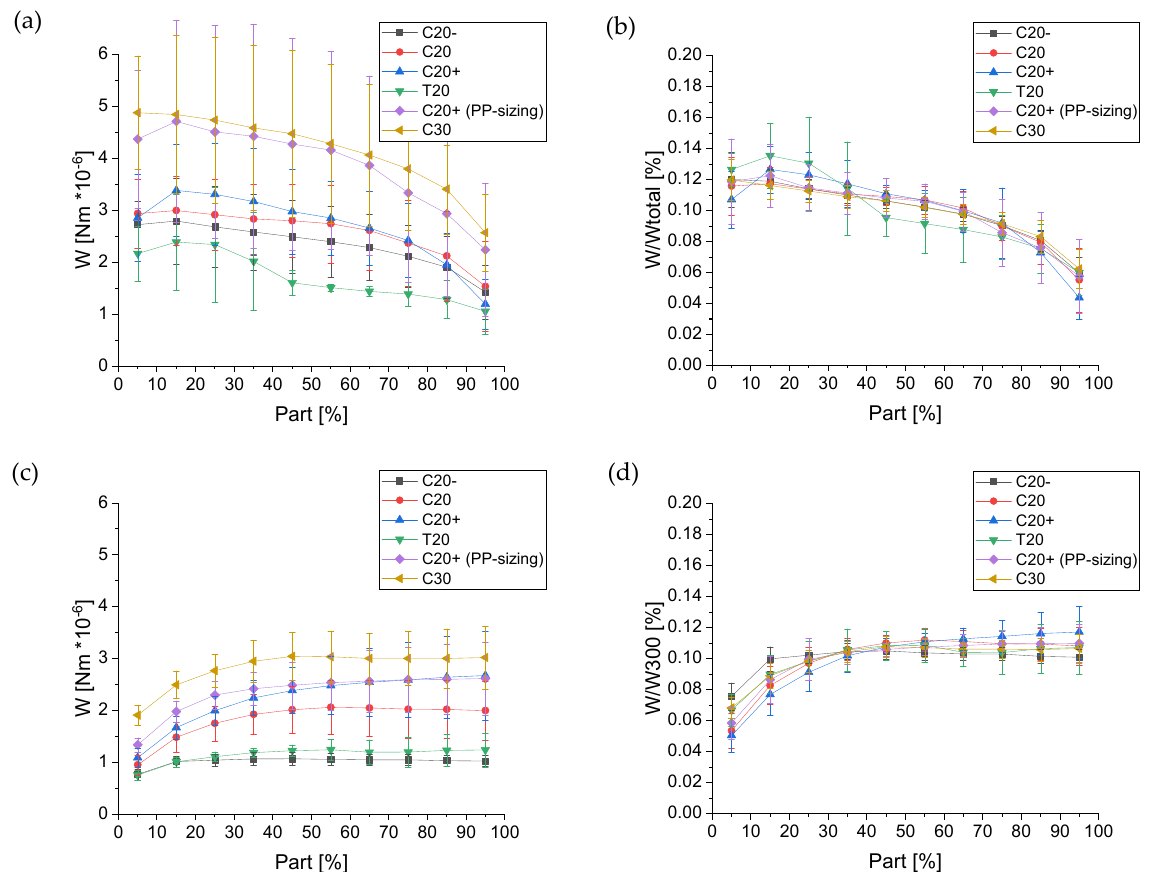
Figure 11. Comparison of ( a ) average progress and ( b ) normalized pull-out work for quasi-static load and ( c ) average progress and ( d ) normalized pull-out work for dynamic SFPO.